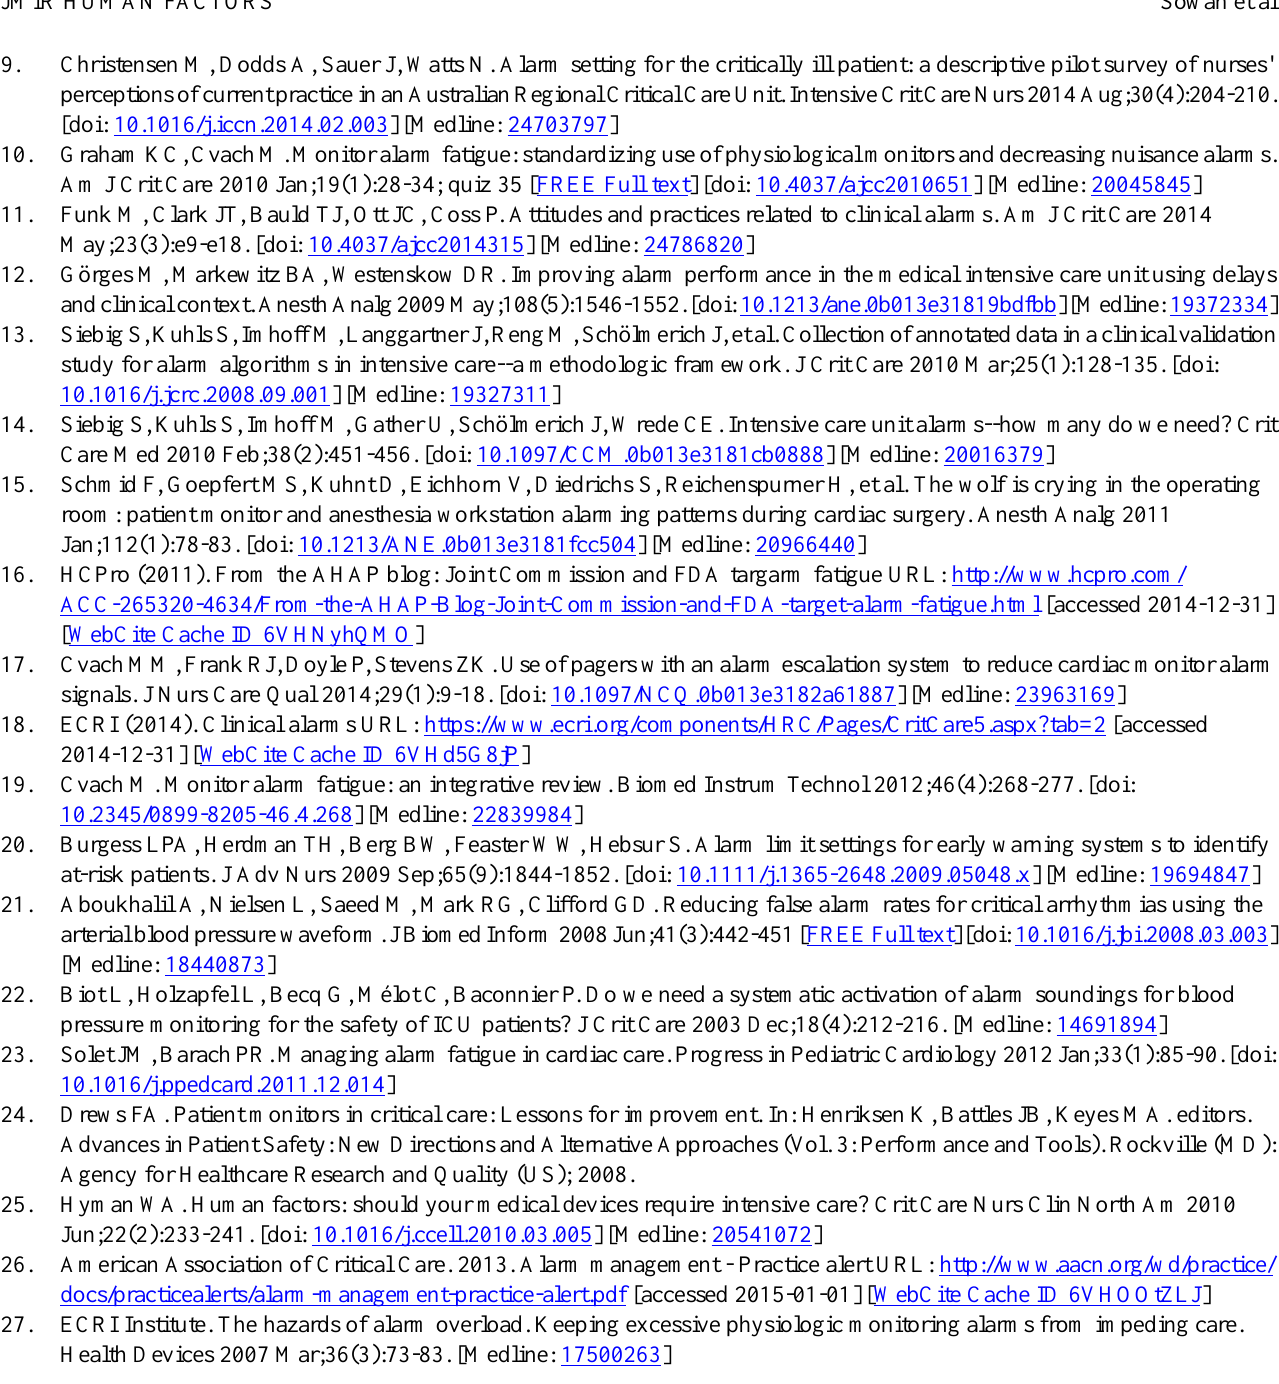
Abbreviations ECRI: Emergency Care Research Institute HTF: Healthcare Technology Foundation ICU: intensive care unit JC: Joint Commission NPSG: National Patient Safety Goal TCICU: transplant/cardiac